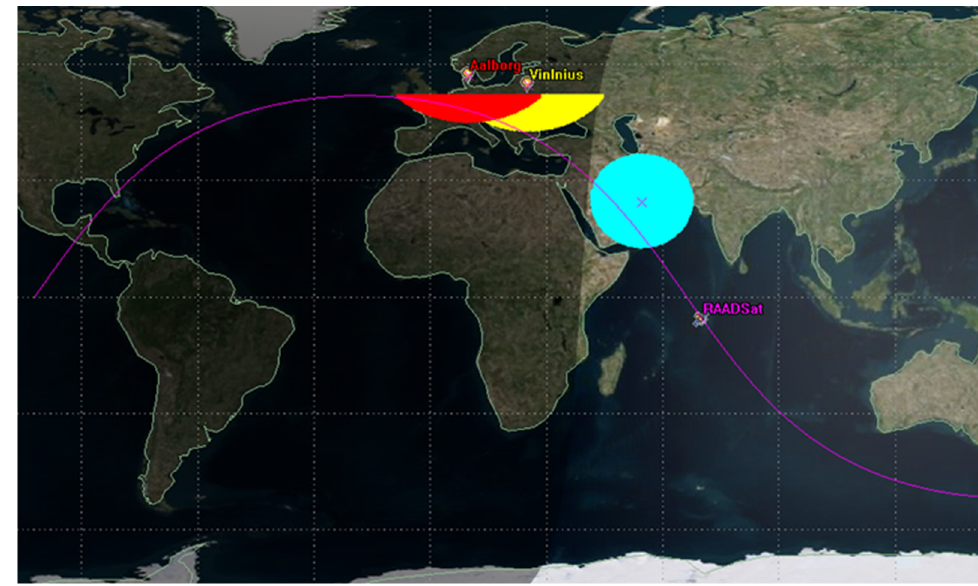
Figure 2. Light-1 ground station coverage.